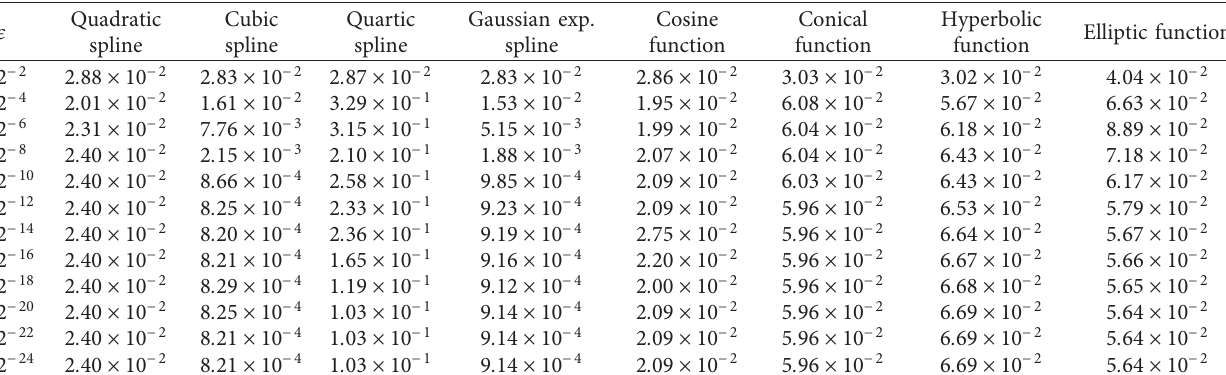
Table 10: Maximum absolute errors for Example 3 for different values of ϵ with quadratic basis